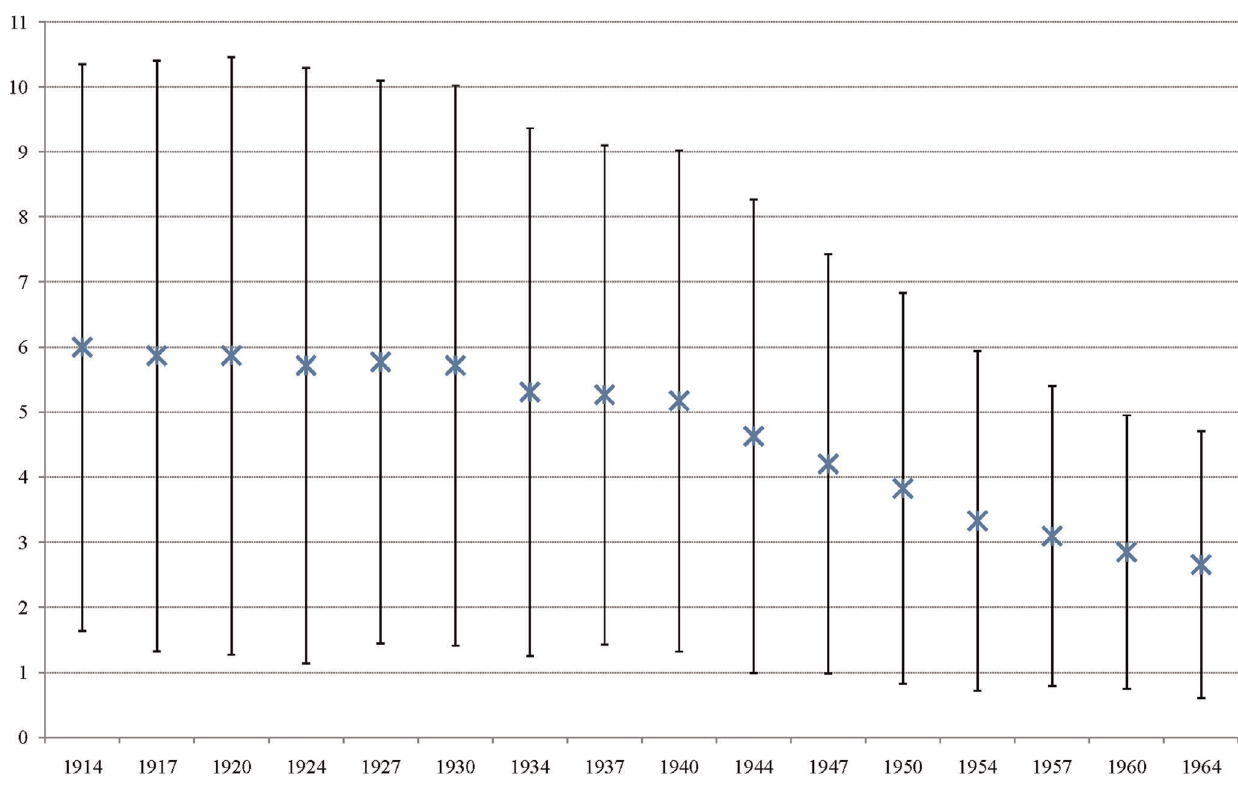
Figure 2. Average Number of Children per Woman by Cohorts (1914–1964). Source: PNAD 1992 to 2009. Author’s tabulation.